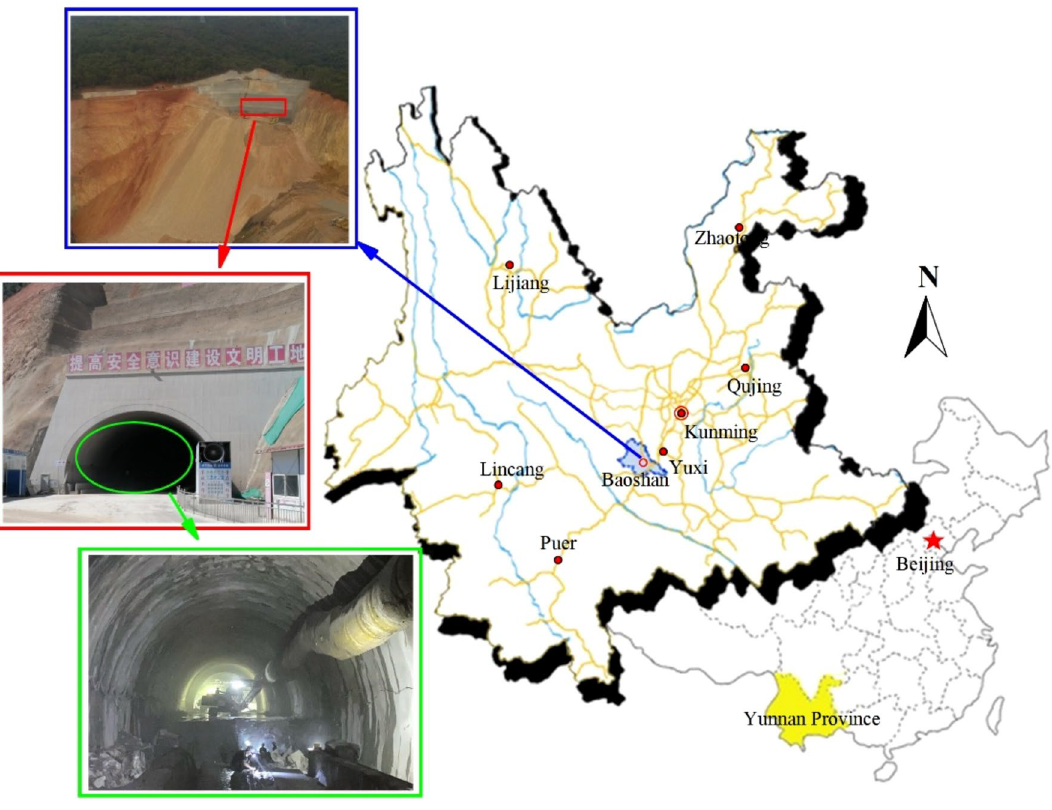
Figure 8. Overview of the Baoshan